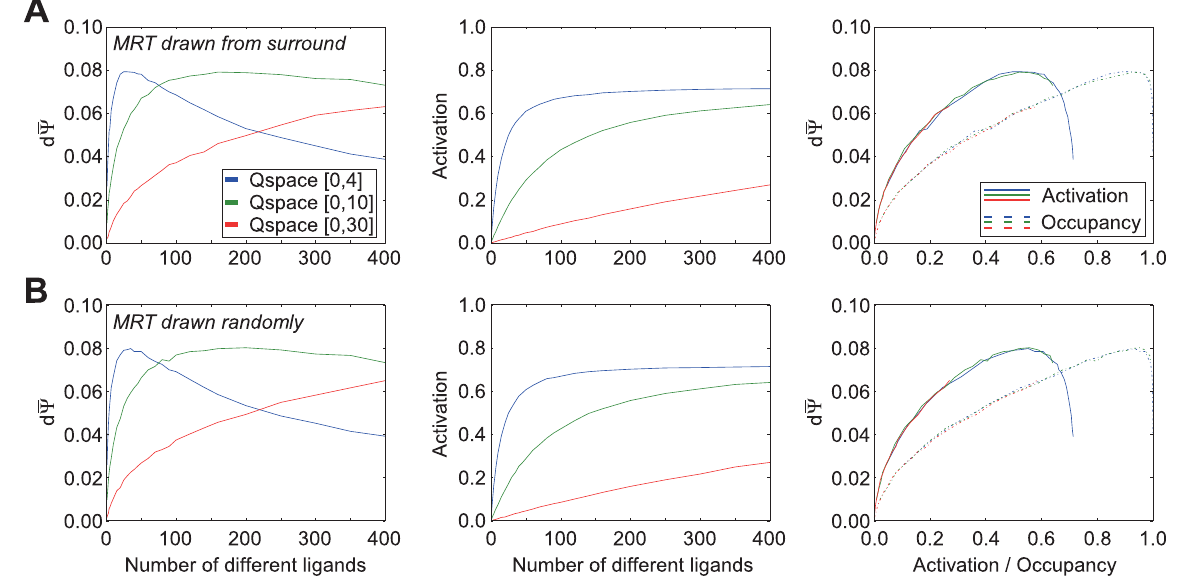
Fig 9. Absence of any effect of glomerular position on the MRT effect. To generate a 10x10 toroidal map of glomeruli, the number of receptors was increased to 100 for all plots. A. Restricting secondary glomerular inputs to those eight receptors primarily targeting immediately neighboring glomeruli yields patterns of neighborhood-based reciprocal relationships. B. Effects based on MRT glomeruli receiving their inputs from a random set of receptors. There were no discernable differences in discrimination capacity peaks or relationships between the two architectures. The relative contributions of the nine receptor inputs were based on experimental data as in Fig 8H.